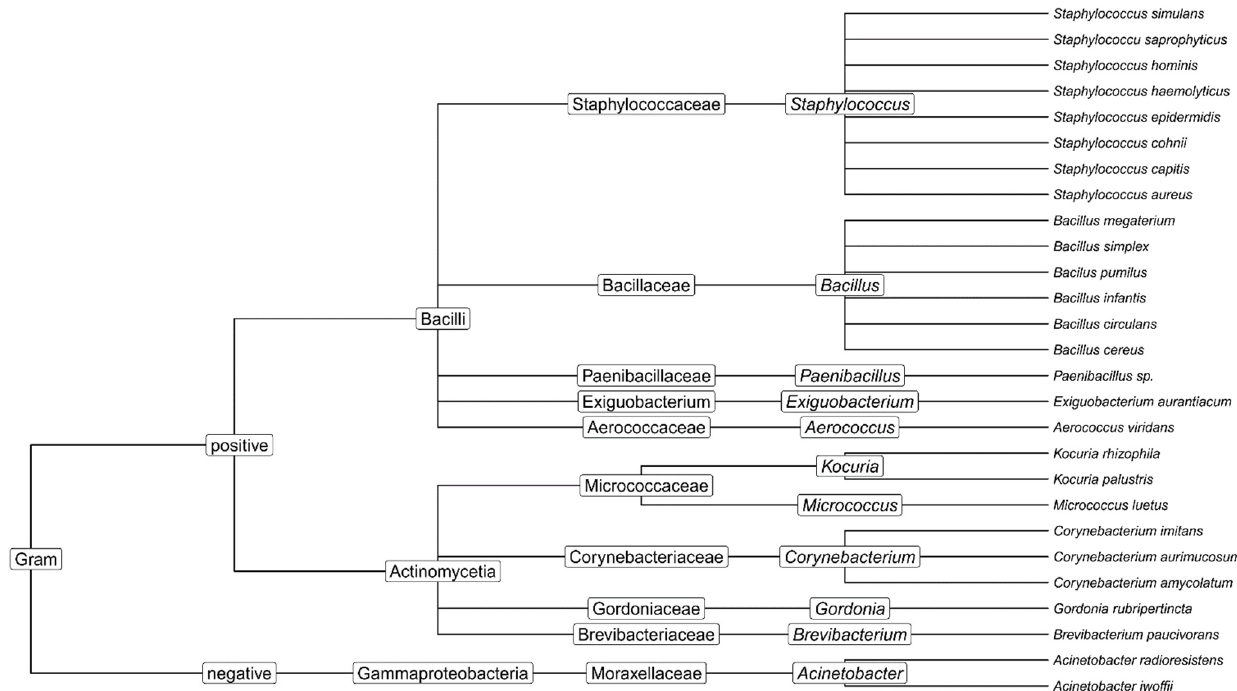
Figure 2. Dendrogram of the cluster analysis results for identified species found across institutions and